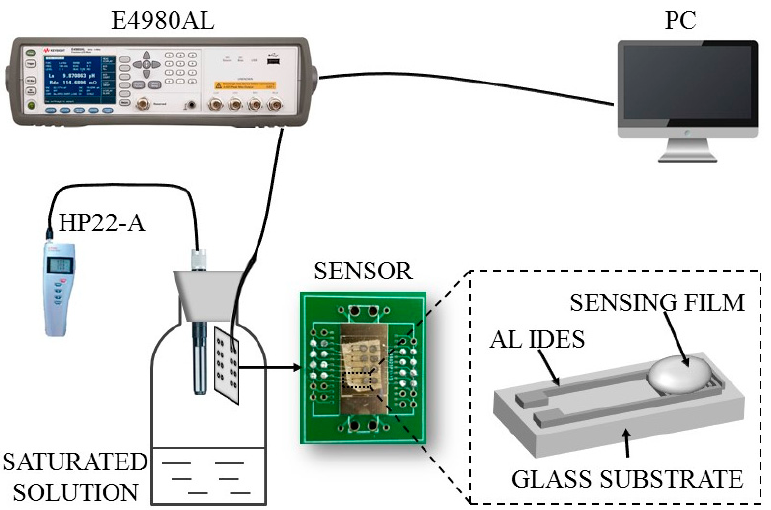
Figure 1. Schematic of the humidity measurement system and of the constructed humidity